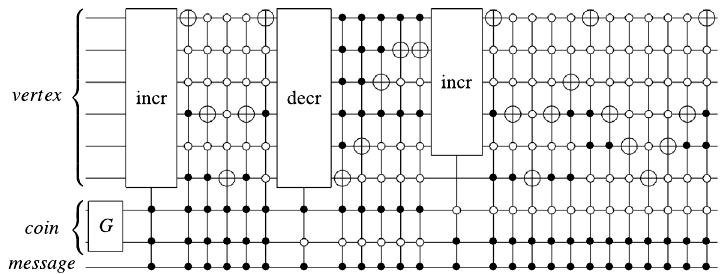
Figure 4. Quantum circuit implementing QHFL with the liveliness parameter τ controlled by message bit 1.